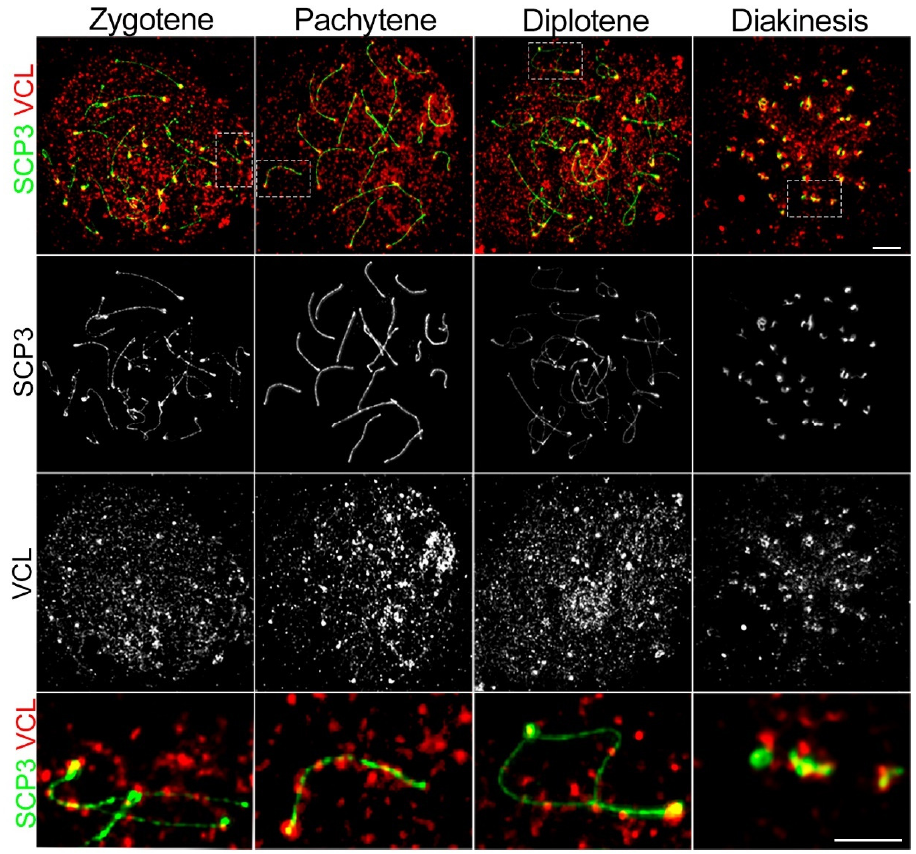
Figure 2. Subnuclear localization of VCL during prophase I in the spermatocyte chromosomal spreads. Immunofluorescence of spermatocyte spreads from adult mouse males shows localization of VCL (red) and SCP3 (green). Data indicate dynamic changes in VCL localization during meiotic prophase I substages. VLC started to accumulate in the zygotene stage. In pachytene, VCL localized in defined foci near the centromeric region and decorated paired homologous chromosomes. The decorating pattern dissolved during the diplotene substage, whereas obvious centromeric localization remained until the diakinesis substage. Scale bars correspond to 10 μ m.